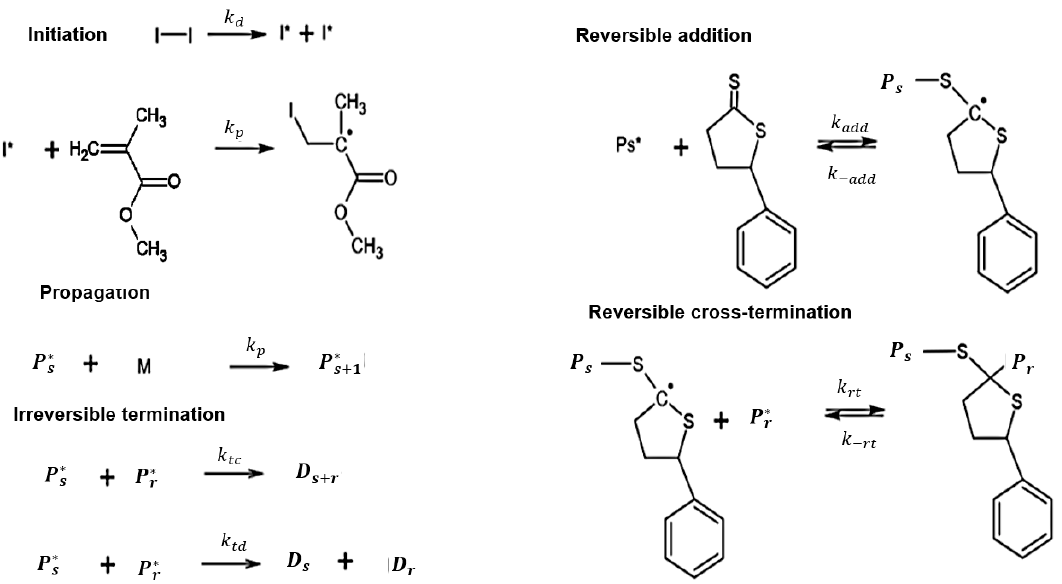
Figure 5. Polymerization scheme for dithiolactone-mediated (DTLM) radical polymerization of vinyl monomers.